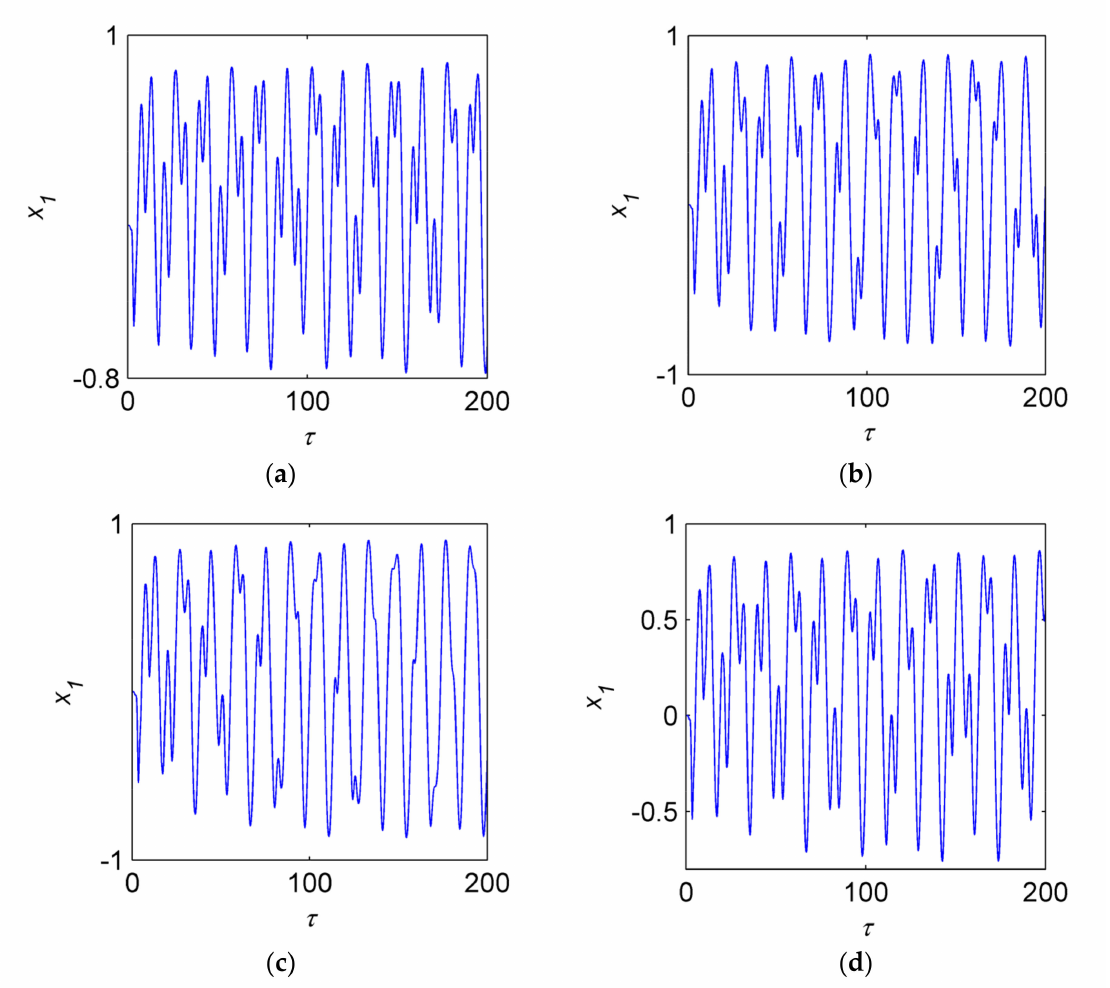
Figure 11. Time history curves of x 1 when ω = 1020 rad/s. ( a ) The oil-filmed system. ( b ) The cracked system. ( c ) The rub-impacted system. ( d ) The coupled